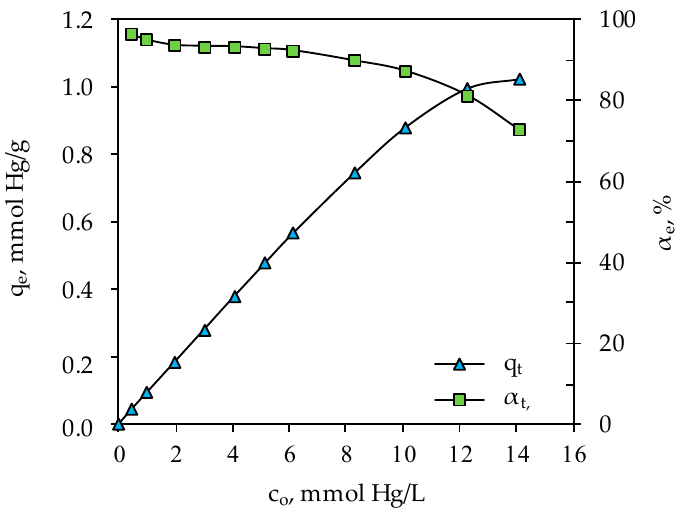
Figure 14. Amount of sorbed Hg(II) and removal efficiency in relation to the initial Hg(II) concentration.